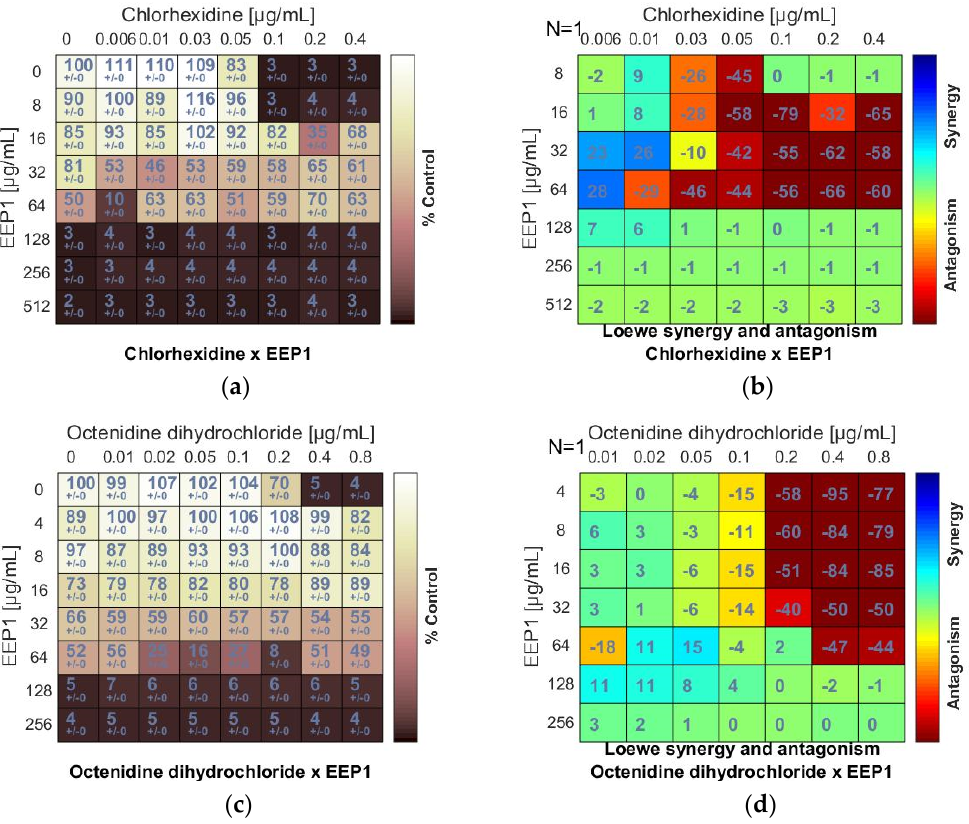
Figure 2. Antagonistic effect between ethanolic extract of propolis and antiseptic (chlorhexidine and octenidine dihydrochloride) against S. aureus ATCC 25923: (a , c) Checkerboard assay results showing the percentage growth inhibition compared with control; ( b , d ) Results showing synergy/antagonism calculations of synergy scores determined by Combenefit software (the difference between the predicted additivity and the observed viability) for the Loewe model. A heat map represents the level of synergy (blue color) or antagonism (red color) at each concentration. A positive score indicates synergy, a score of 0 is additive, and a negative score indicates antagonism. Table 4. The checkerboard analysis of drug interaction between EEPs and antipyretics (IB—ibu-